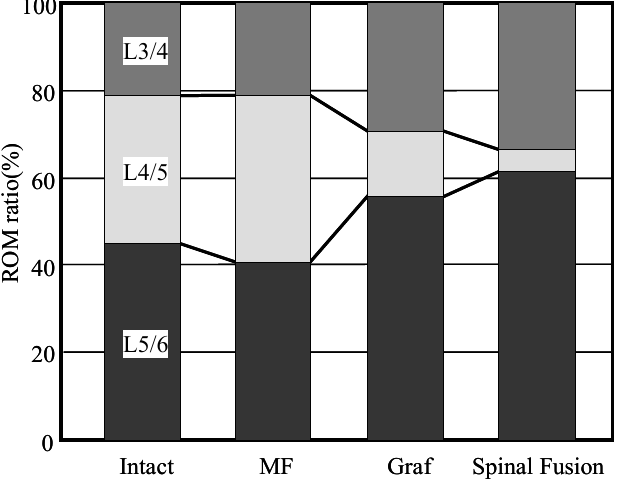
Fig. 5 Distribution of the range of motion for each instrumented model. At L4/5, the ROM with the Graf system was significantly less than in the intact and MF groups, while with spinal fusion, the ROM was significantly less than in all three other groups.